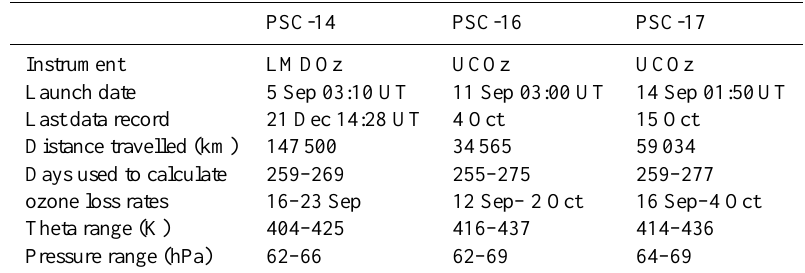
Table 1. Details of balloon flights analysed for ozone loss rates